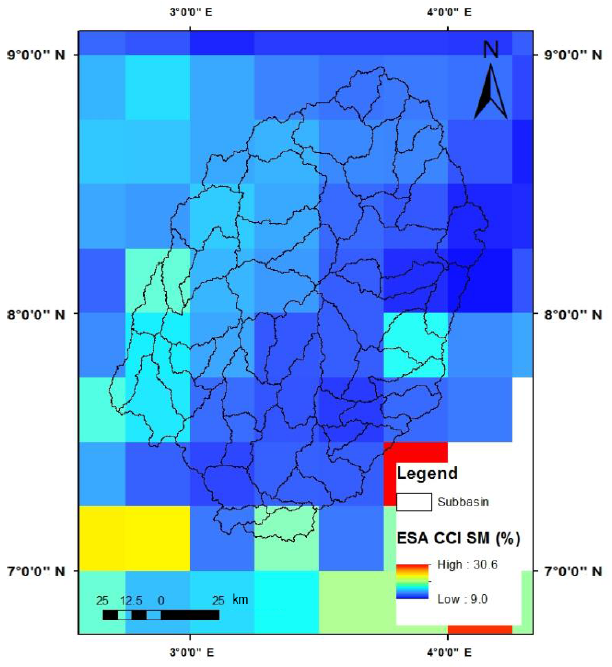
Figure E1. Mean monthly soil moisture of ESA CCI over the entire Ogun River Basin for